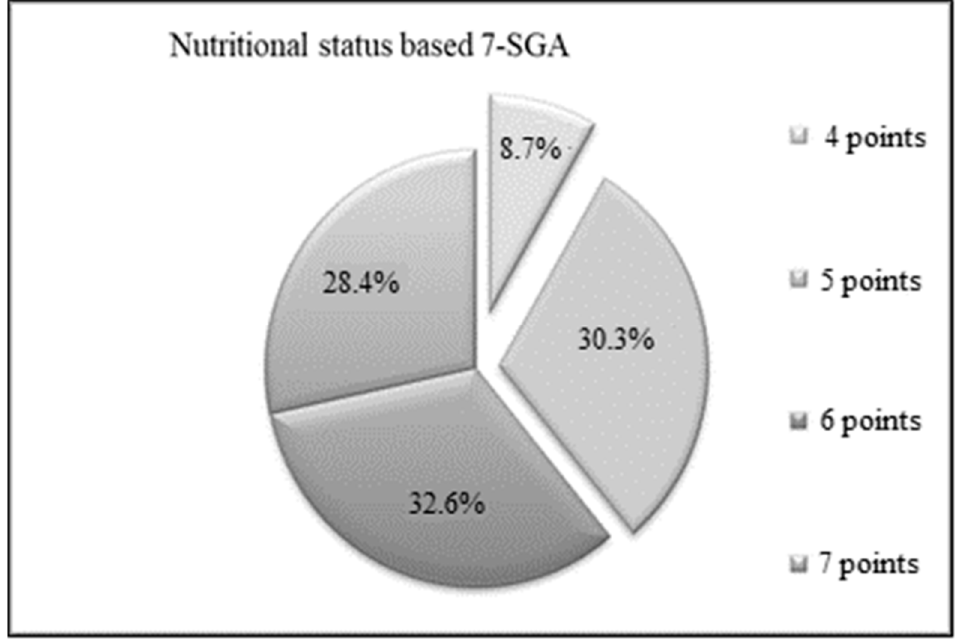
Figure 2. The nutritional status according 7-point SGA in KTRs. Albumin level was 38.54 ± 3.80 g/L and prealbumin 27.83 ± 7.30 mg/dL and were